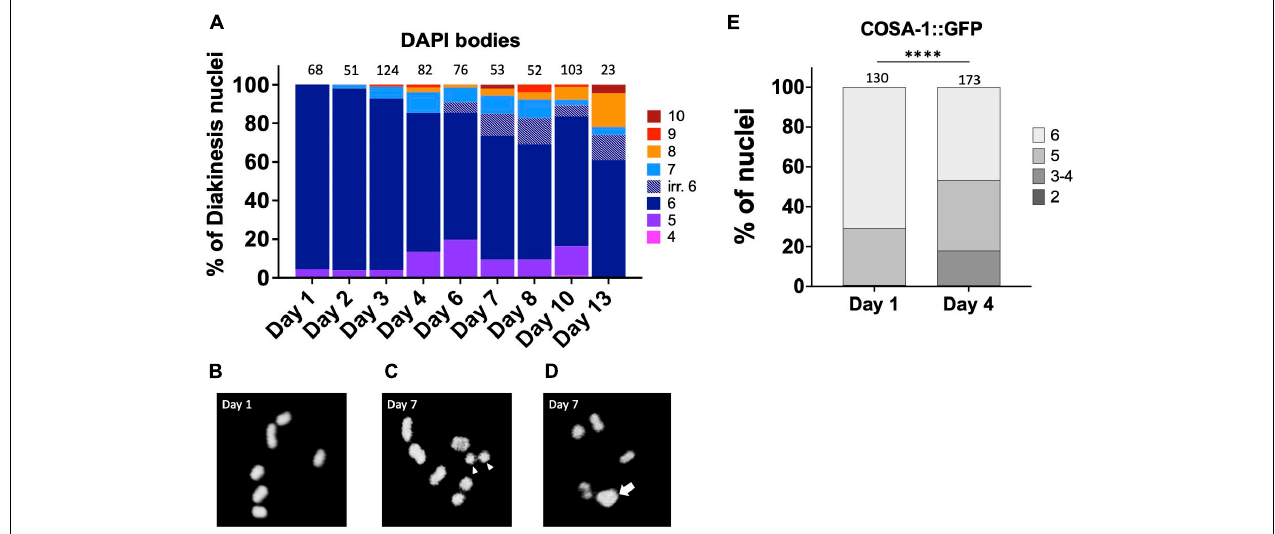
FIGURE 1 | Chiasmata formation is compromised in aging germ lines. Crossover formation is assessed by the number of DAPI-staining bodies at diakinesis. (A) Quantification of DAPI-bodies in N2 diakinesis nuclei from the indicated ages. (B–D) Representative DAPI-stained images of young (B) and aged (C,D) N2 worms showing bivalents (day 1), “separated bivalents” (arrowheads) and fusion (arrow). (E) Percent of late pachytene-stage nuclei containing the indicated number of COSA-1 foci in gfp::cosa-1 worms. Numbers on top of bars indicate the total number of nuclei analyzed per age. Statistical significance was determined using Chi-square test. ∗∗∗∗ p <